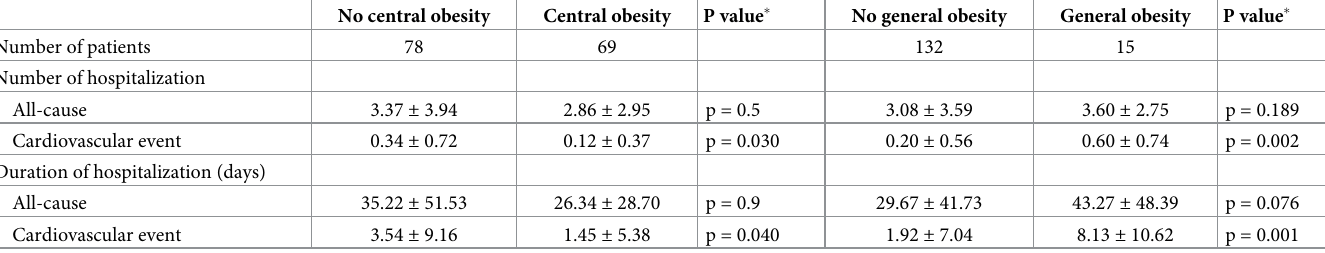
Table 6. Relation between hospitalization and general versus central obesity in non-frail